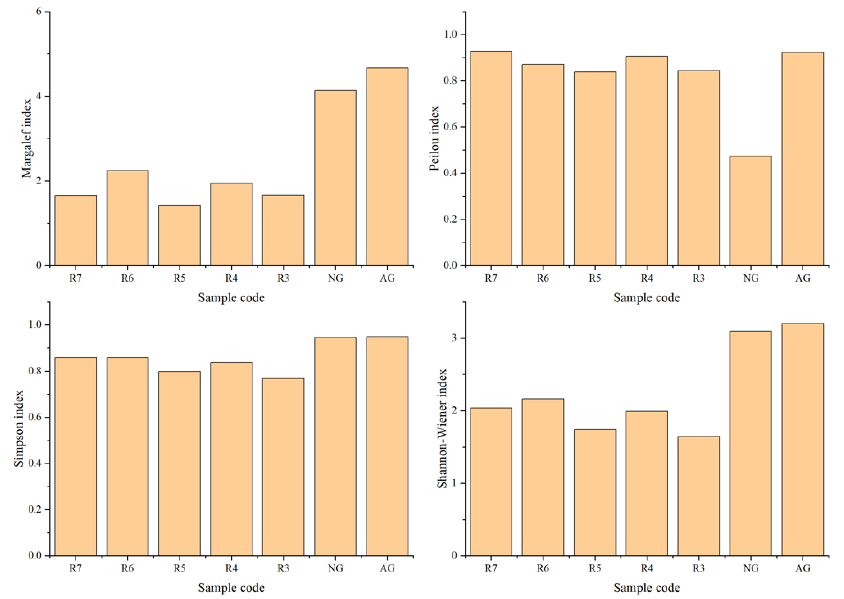
Figure 2. Diversity indices of understory herbaceous plant community in different restoration